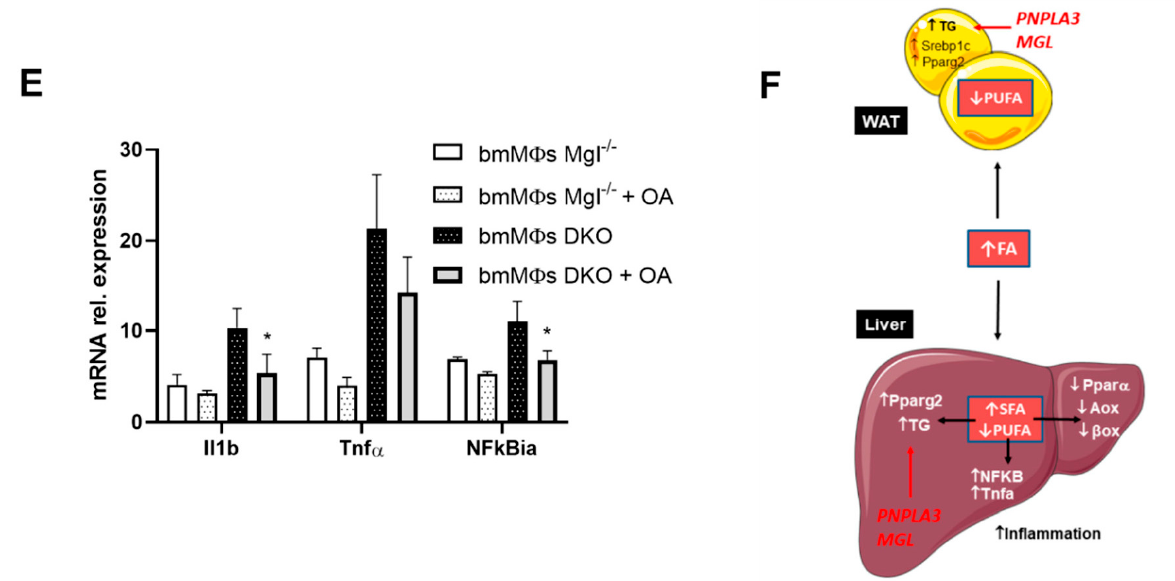
Figure 4. Bone marrow derived macrophages (BMDMs) from DKO mice are proinflammatory and their phenotypes can be partially reversed with oleic acid (OA) treatment. ( A ) Gene expression of proinflammatory Il1b, Tnfa, and nfkbia increased along cholesterol synthesis as shown by Srebp2, Hmgcr, and LDLr . ( B ) Increased concentration of proinflammatory PGE2 in BMDM medium. ( C ) BMDM conditioned media strongly activated NFKB pathway in U937. ( D ) When treated with LPS, gene expression of Il1b and Tnfa further increased in BMDMs from DKO . ( E ) Treatment with OA diminished gene expressions of Il1b, Tnfa, and Nfkbia in BMDMs from DKO . ( F ) Proposed mechanism of action showing decreased PUFA in the AT driving TG accumulation and inflammation, with concomitant increase in SFA in the liver and TG with inflammation and decreased b-oxidation. Results are expressed as mean ± S.D.; * p < 0.05 for BMDMs Mgl − / − versus BMDMs DKO